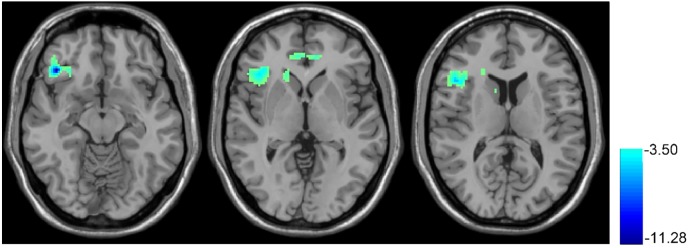
rTMS-induced BEN decrease. Paired t-test, when compared with the baseline condition (no rTMS), showed the 10 days rTMS treatment-induced CBF decrease in the right orbital part of the inferior frontal gyrus and right insula. In the thresholded t-map, blue means lower after rTMS treatment, p < 0.01, AlphaSim corrected (cluster size >270).